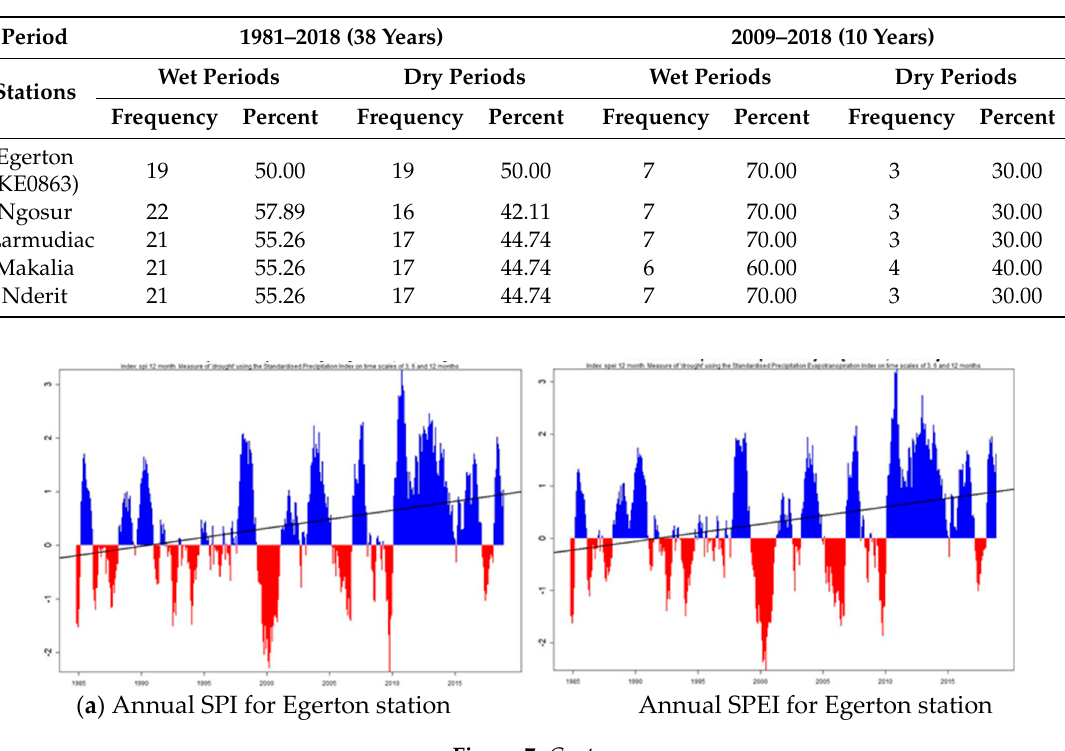
Table 5. Distribution of wet and dry periods for 12-month SPI for Lake Nakuru catchment from 1981 to 2018 and from 2009 to 2018.